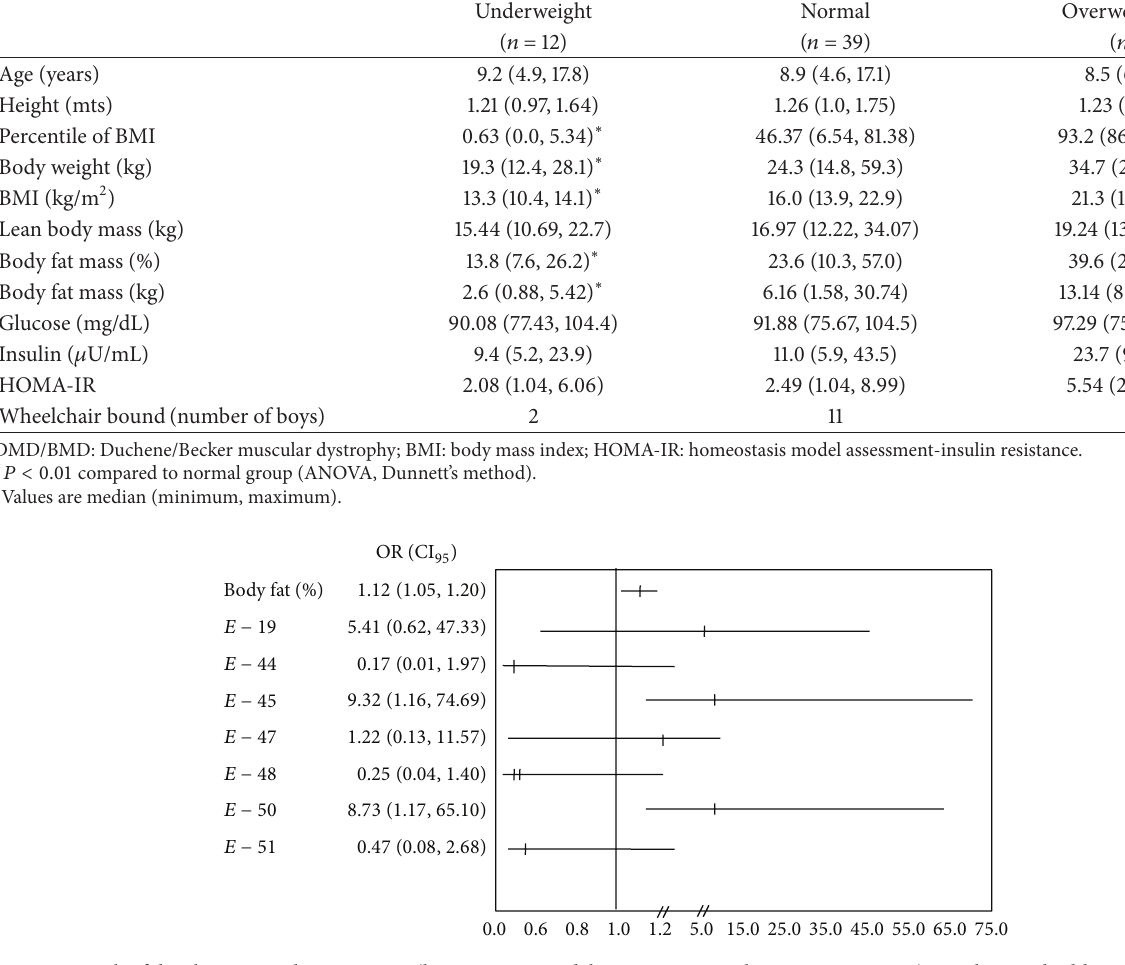
Figure 3: Risk of developing insulin resistance (homeostasis model assessment-insulin resistance > 3.16). 𝑃 values and odds ratio calculated by logistic regression model. CI, confidence interval. Data adjusted by % body fat mass. 𝐸 =